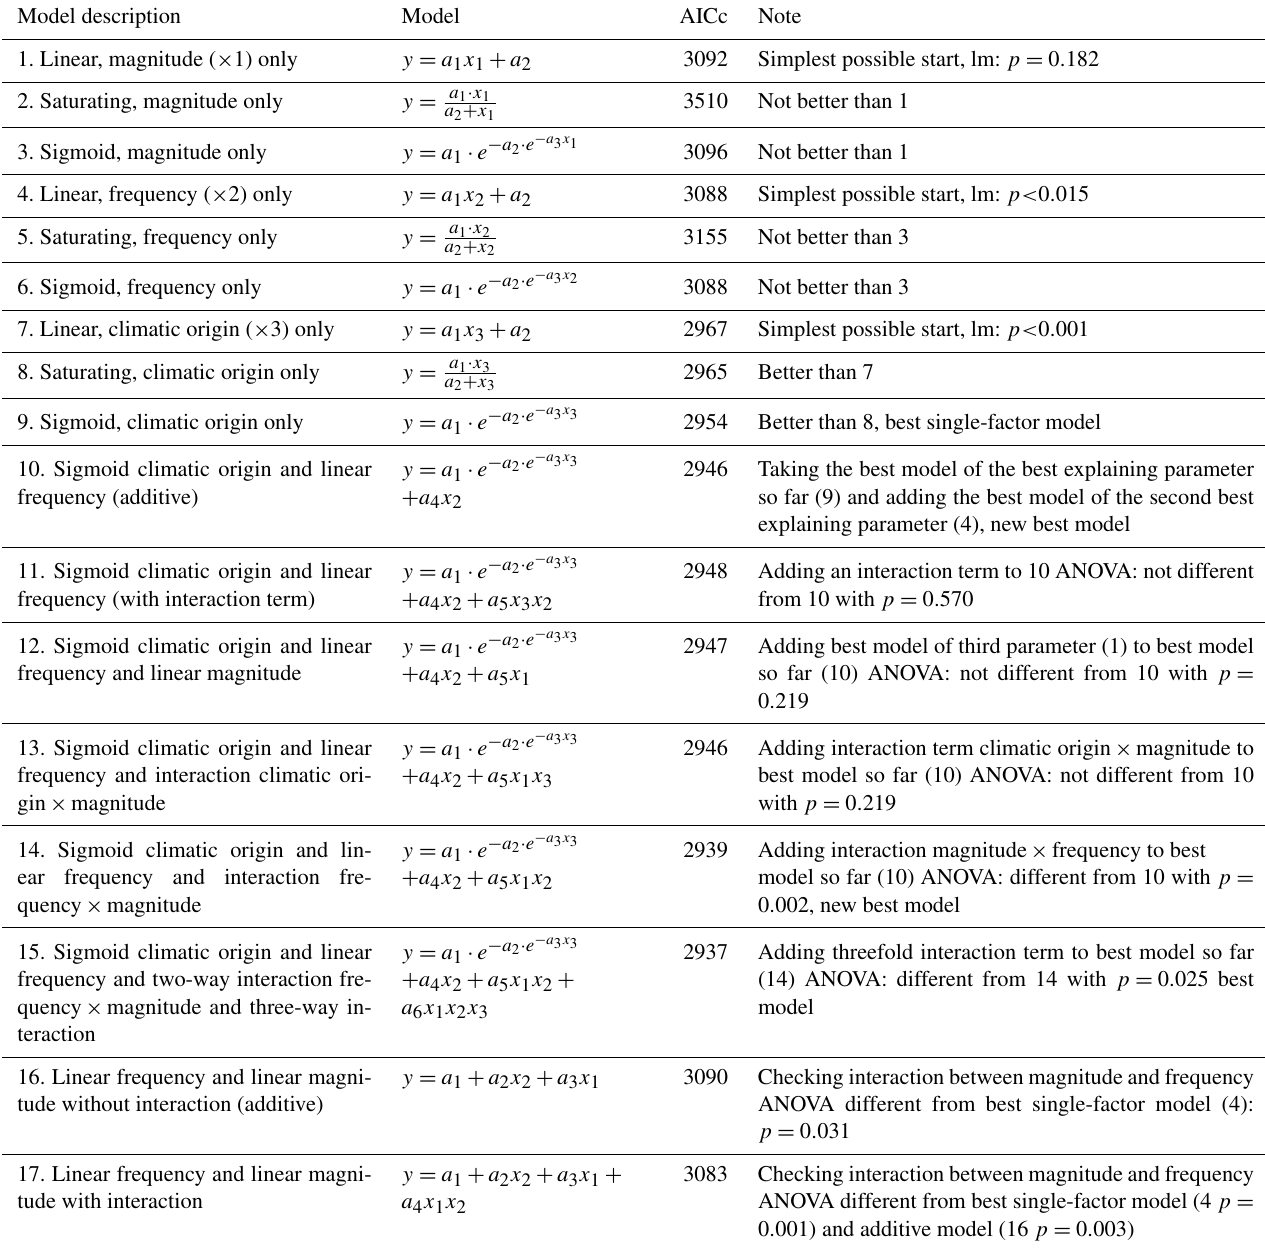
Table 4. Results of the hierarchical regression analysis for ammonium concentrations of beech forest soils to changes in FTC magnitude ( x 1 ), FTC frequency ( x 2 ), and climatic origin ( x 3 ; expressed as mean minimum winter temperature at origin) at the end of the FTC treatments. Tested are linear, saturating (Michaelis–Menten function), and sigmoid (Gompertz function) relationships on the single environmental drivers and their interactions. Bold AICc (Akaike information criterion corrected for small sample sizes) values indicate the best model. AICc in italics indicate the best single-factor models. a 1 to a n are the fitted parameters of the respective model. FTC: freeze–thaw